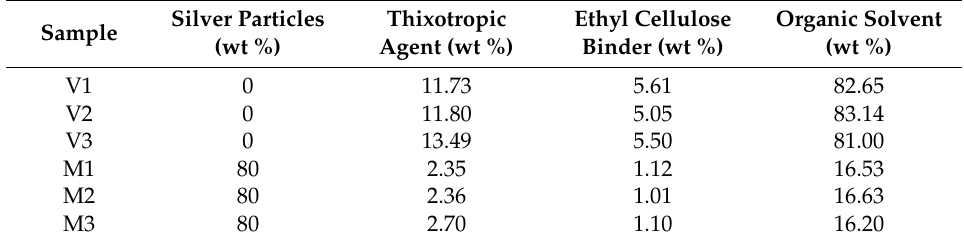
Table 1. Overview of investigated model vehicles (V1, V2, and V3) and model silver pastes (M1, M2, and M3). Vehicles included thixotropic agent and ethyl cellulose binder at varying mixing ratios. Model silver pastes additionally contained 80 wt % (corresponding to 36.4 vol %) spherical silver particles ( x 50 = 1.5 µ